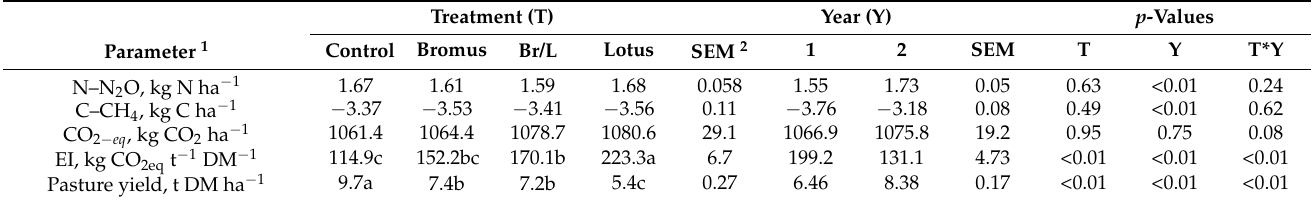
Table 5. Mean annual cumulative emissions of N–N 2 O, C–CH 4 and CO 2 − eq , pasture yield and emission intensity (EI) of different pastures during the two experimental years. Year (Y) p